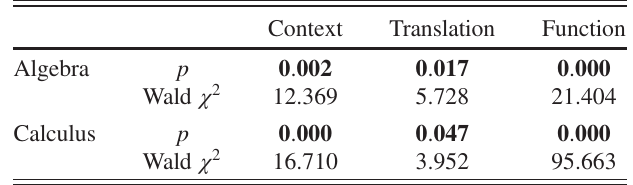
TABLE IV. p values and Wald χ 2 for the main effects of the item variables on the accuracy of student answers. Significant effects are given in